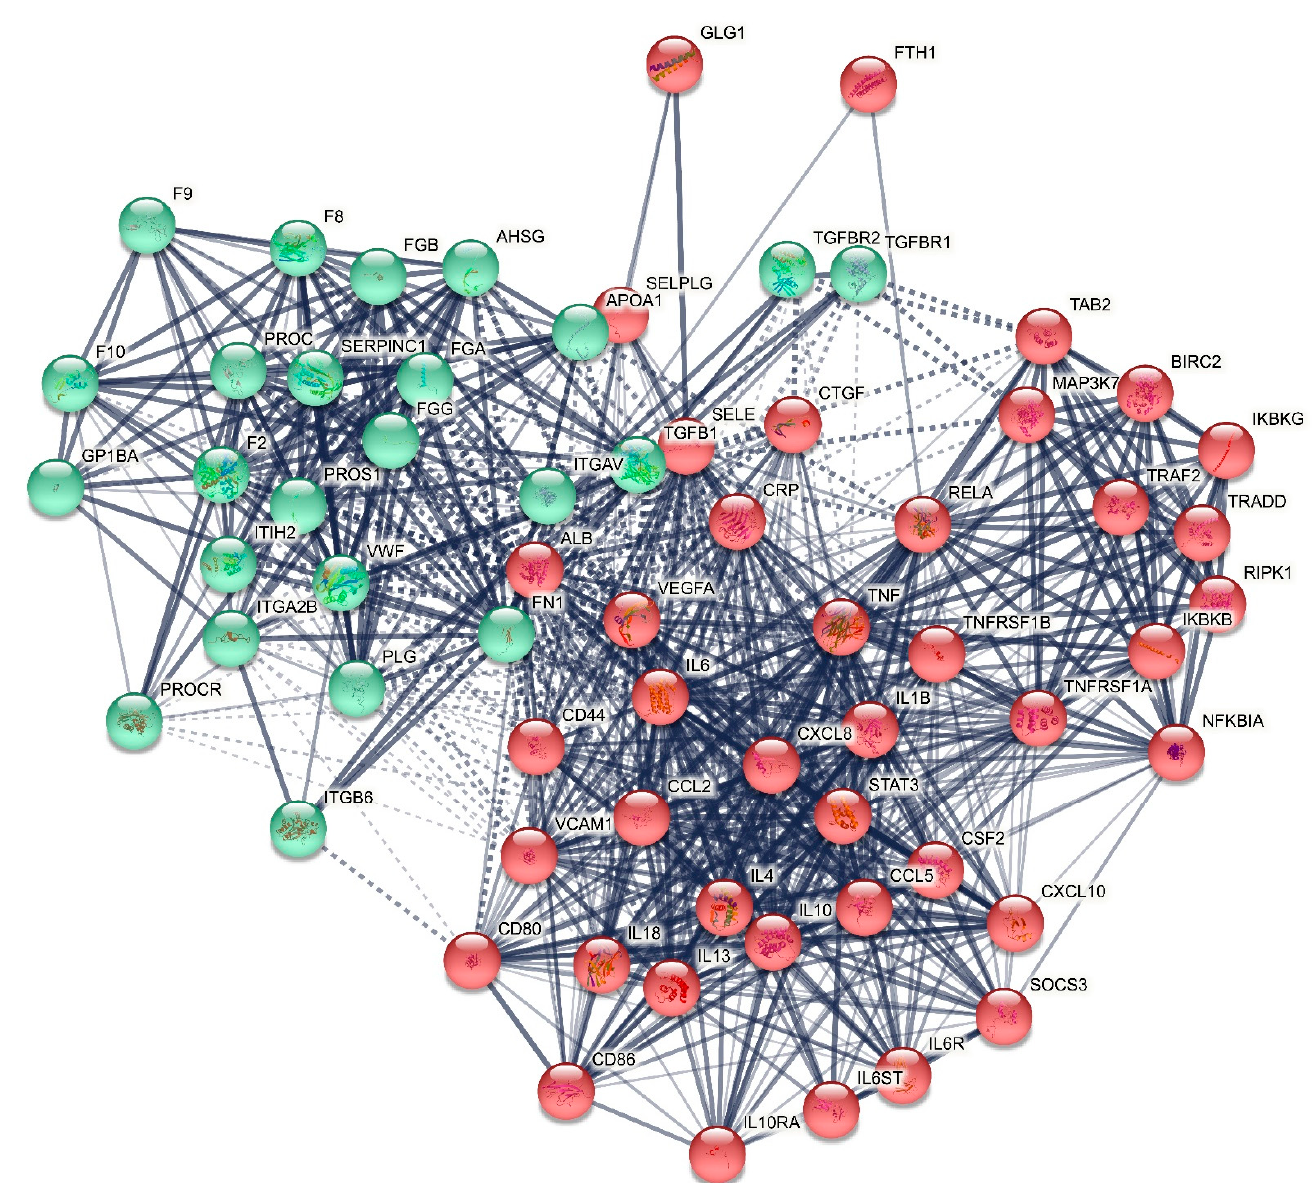
Figure 1. First-order protein network showing the results of Markov Clustering (MCL) analysis: (1) a first immune cluster (red bullet icons) was centered around ALB (albumin), CRP (C-reactive protein), IL10 (interleukin 10), IL6 (interleukin 6), SELE (E-selectin), TGFB1 (transforming growth factor beta 1), TNF (tumor necrosis factor), and VCAM1 (vascular cellular adhesion molecule 1), and (2) a second hemostasis fibrin-clot cluster (green bullet icons) centered around F8 (coagulation factor VIII), FGB (beta-fibrinogen), PROC (protein C), PROS1 (protein S), VWF (von Willebrand Factor), and SERPINC1 (antithrombin).